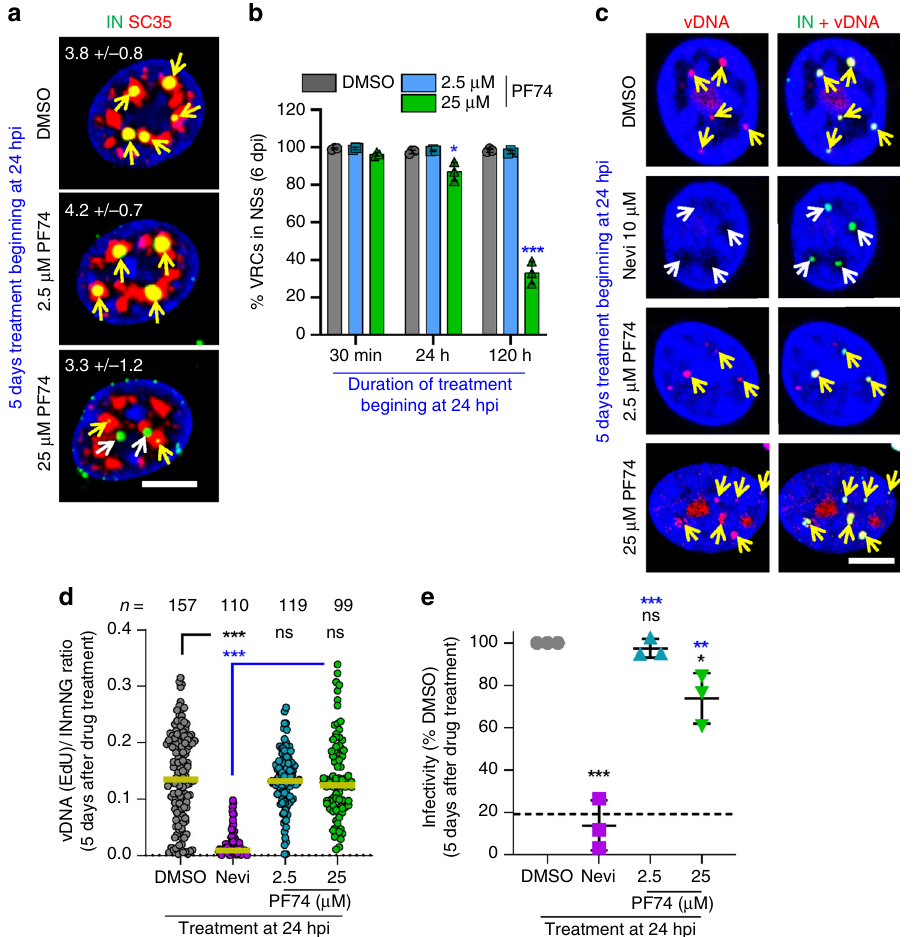
Fig. 7 PF74-resistant nuclear VRC clusters in MDMs continue to synthesize vDNA. Treatment with 25 µ M PF74 promotes slow exit of VRCs from NSs of MDMs, without affecting vDNA synthesis. MDMs were infected with INmNG-labeled HIV-1 ( a – d ) for 24 h, at which time PF74, DMSO, or Nevi was added without ( a , b , e ) or with 5 μ M EdU ( c , d ), and incubated for different time, as indicated. Cells were fi xed and stained for NSs (SC35) ( a , b ) or vDNA ( c , d ). a , b Images and quanti fi cation of the fraction of nuclear VRCs colocalized with SC35 compartments; c , d images and EdU/vDNA staining of nuclear IN puncta after treatment with DMSO and PF74 at 24 hpi. Fluorescence intensities of EdU and INmNG of nuclear VRCs in panel ( d ) were measured and the ratio of EdU/vDNA to INmNG signals was plotted. e HIV-1 infection of MDMs becomes resistant to PF74 treatment after 24 h. MDMs infected with VSV-G pseudotyped pNL4.3 R-E-Luc were treated with indicated drugs beginning at 24 hpi. Cells were cultured for additional 5 days in the presence of drugs; luciferase activity was measured in triplicate and normalized to DMSO control. Each data point in ( e ) represents infectivity from an independent donor, dashed black line denotes the fraction of completion of vDNA synthesis at the time of drug addition (24 h). Scale bars in ( a , c ) are 5 μ m. The average number of nuclear VRCs (±SD) detected in >60 nuclei from three experiments is overlaid on images in ( a ). Mean values ± SEM are shown in panels ( b , e ). Yellow line in ( d ) shows median values at 95% CI from three independent experiments/donors for >80 nuclei; the total number of nuclear IN puncta analyzed is shown. Signi fi cance in ( b ) and ( e ) (black — relative to DMSO, blue — nevirapine) was determined by two-tailed Student ’ s t test. p